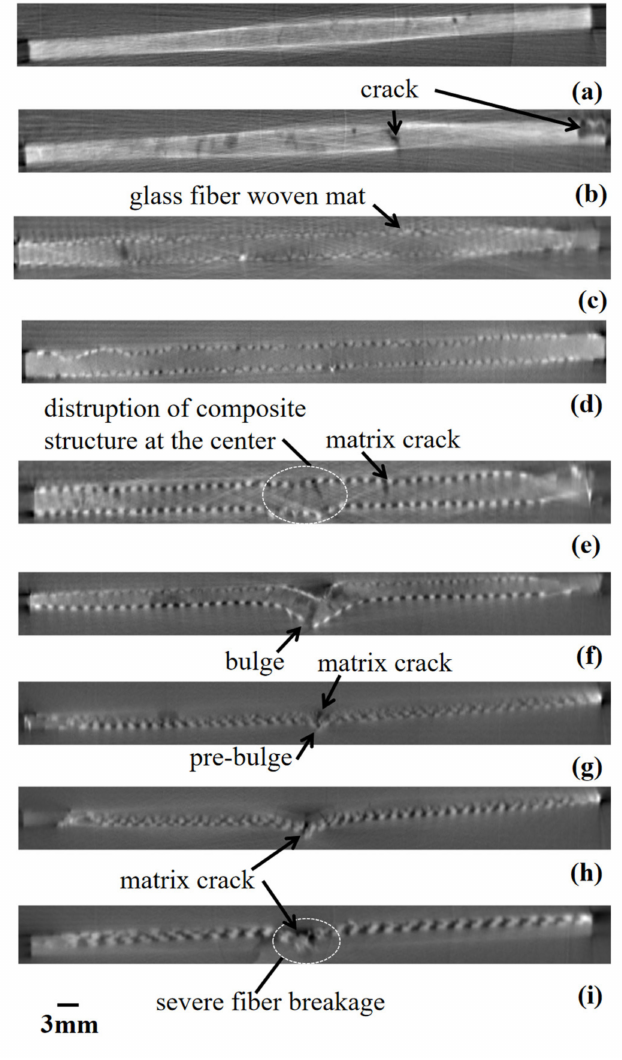
Figure 18. CT scan of composite horizontal cross-section: ( a ) P 1.0 J, ( b ) P 2.0 J, ( c ) GPG 2.0 J, ( d ) GPG 3.0 J, ( e ) GPG 6.0 J, ( f ) GPG 9.0 J, ( g ) GGGG 9.0 J, ( h ) GGGG 10.5 J and ( i ) GGGG 12.0